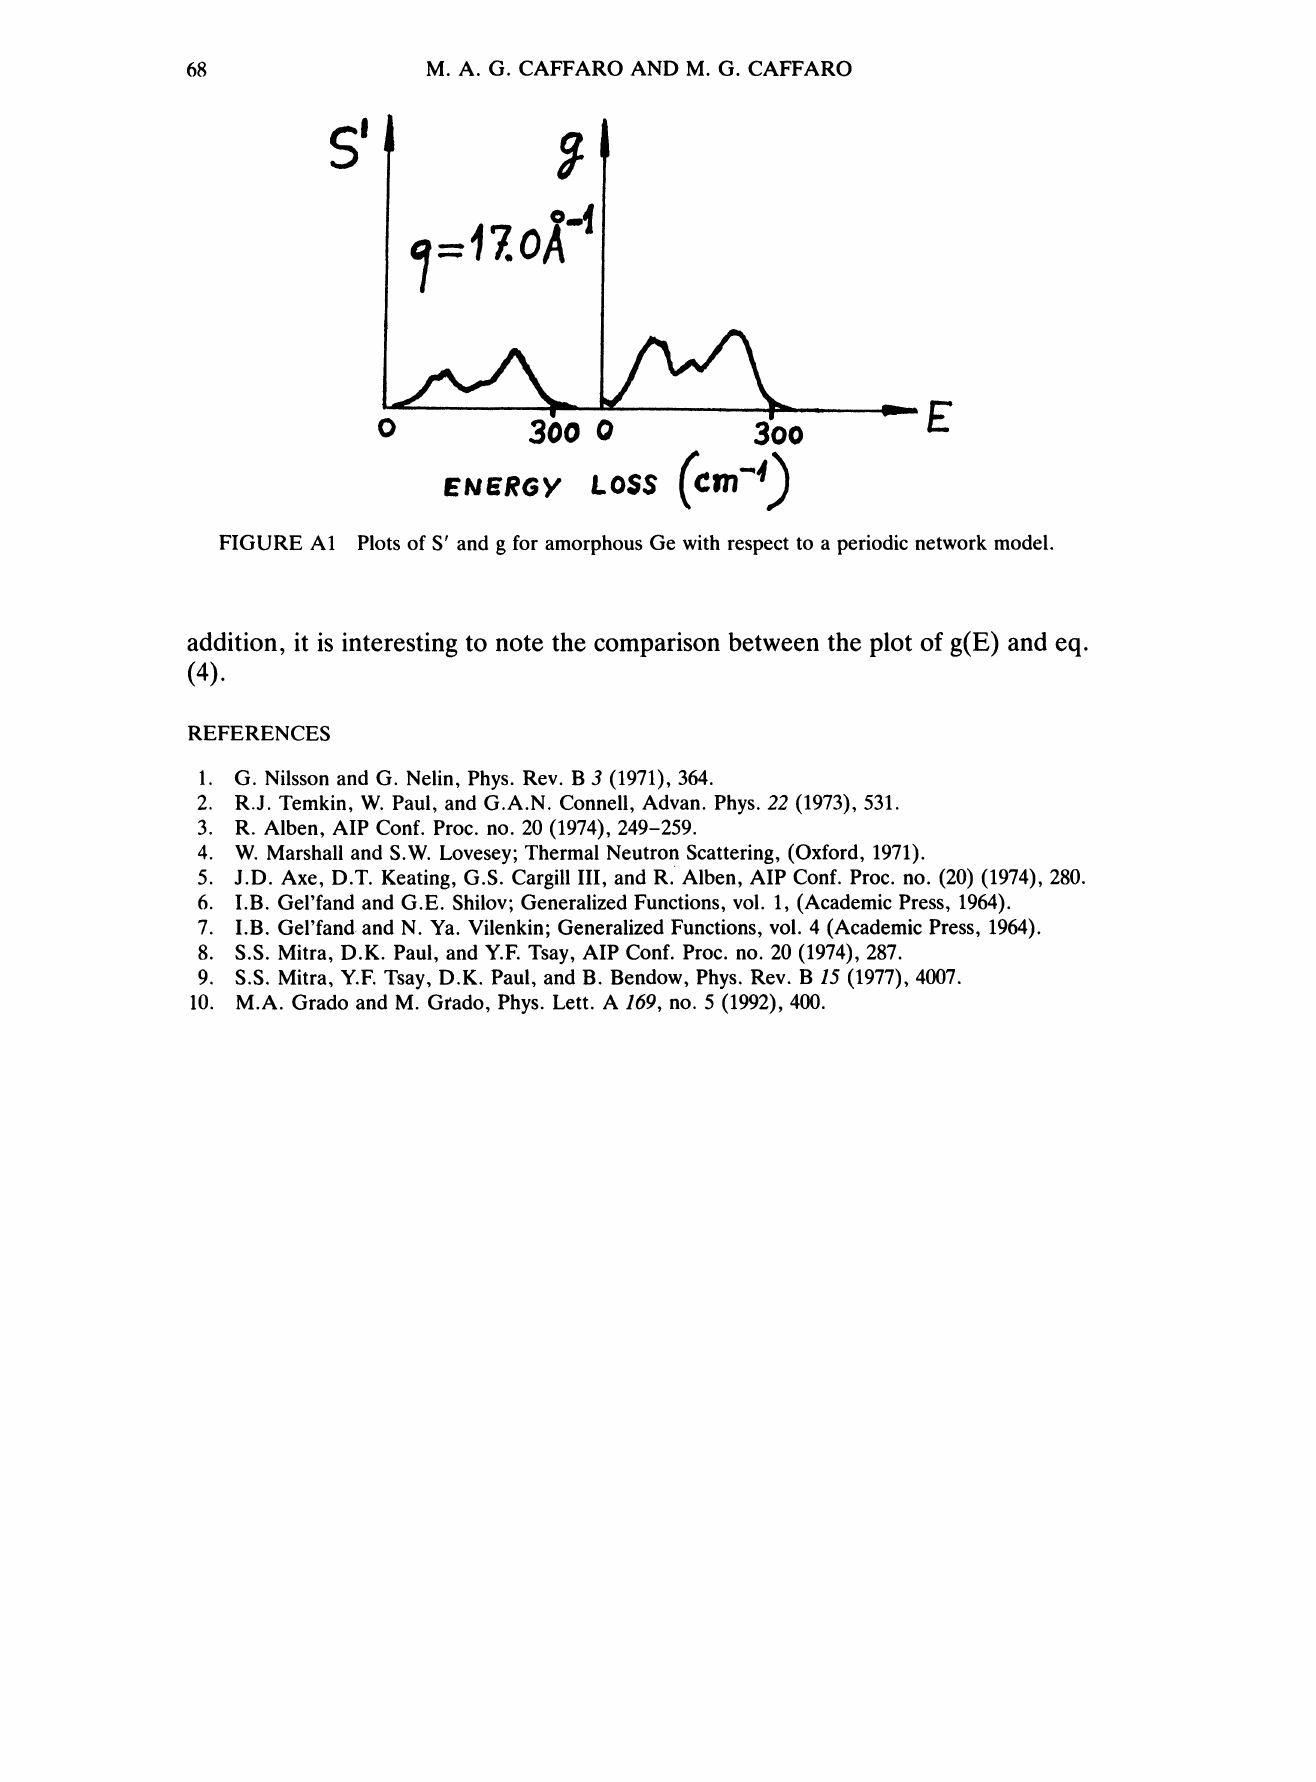
FIGURE A1 Plots of S’ and g for amorphous Ge with respect to a periodic network model.